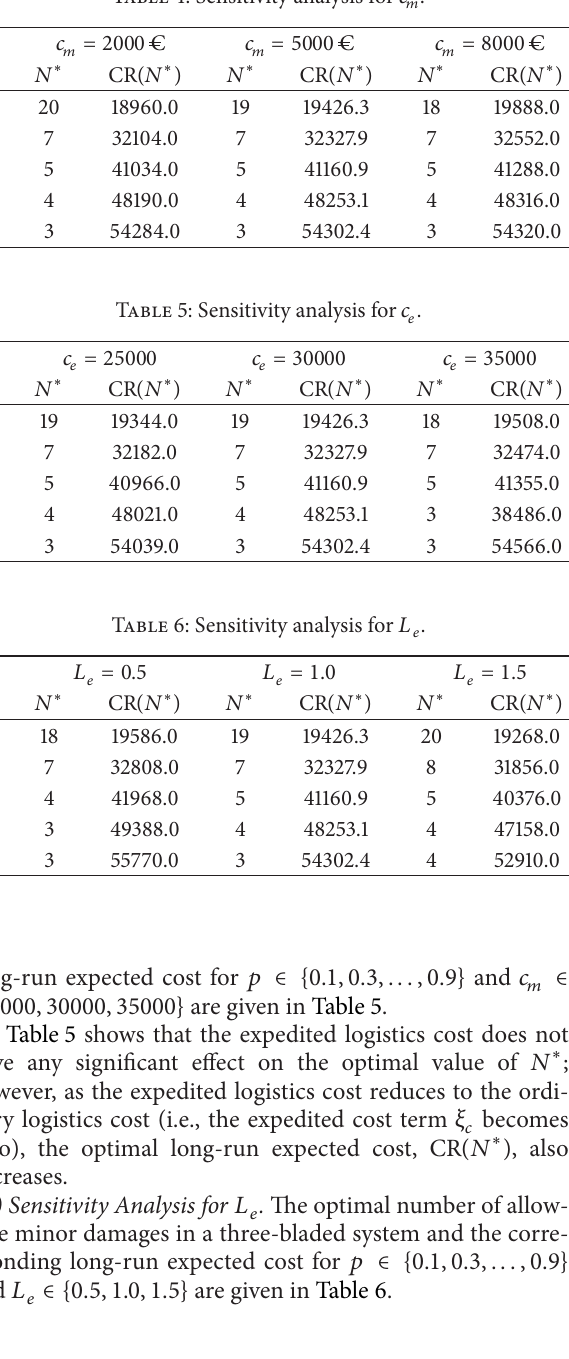
Table 4: Sensitivity analysis for 𝑐 𝑚 .